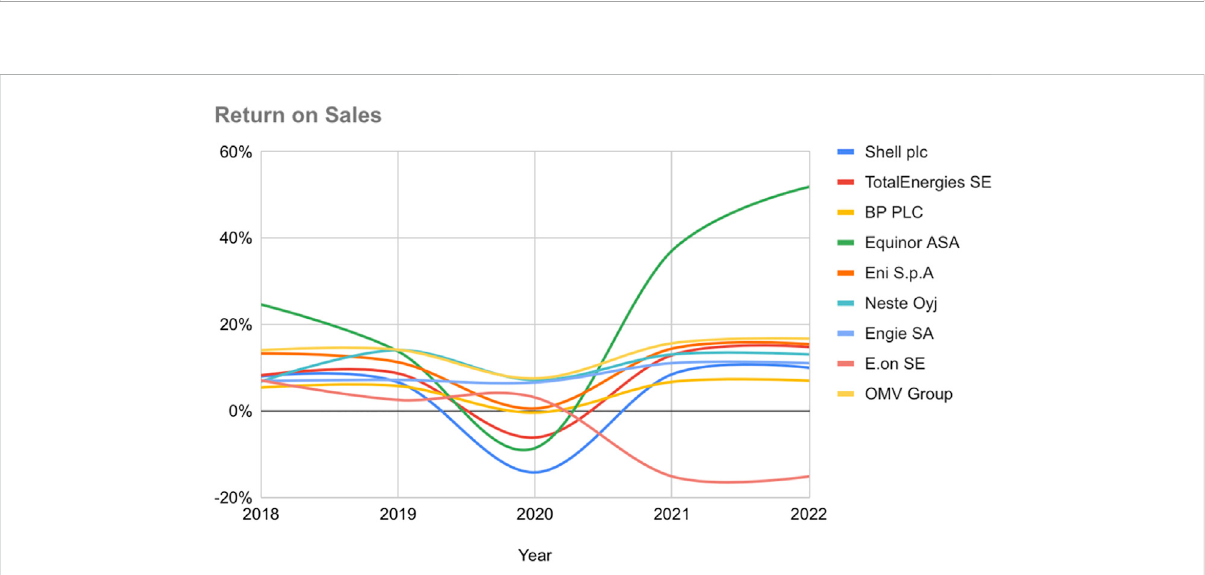
FIGURE 2 Line chart: Return on assets. Source: Own elaboration.